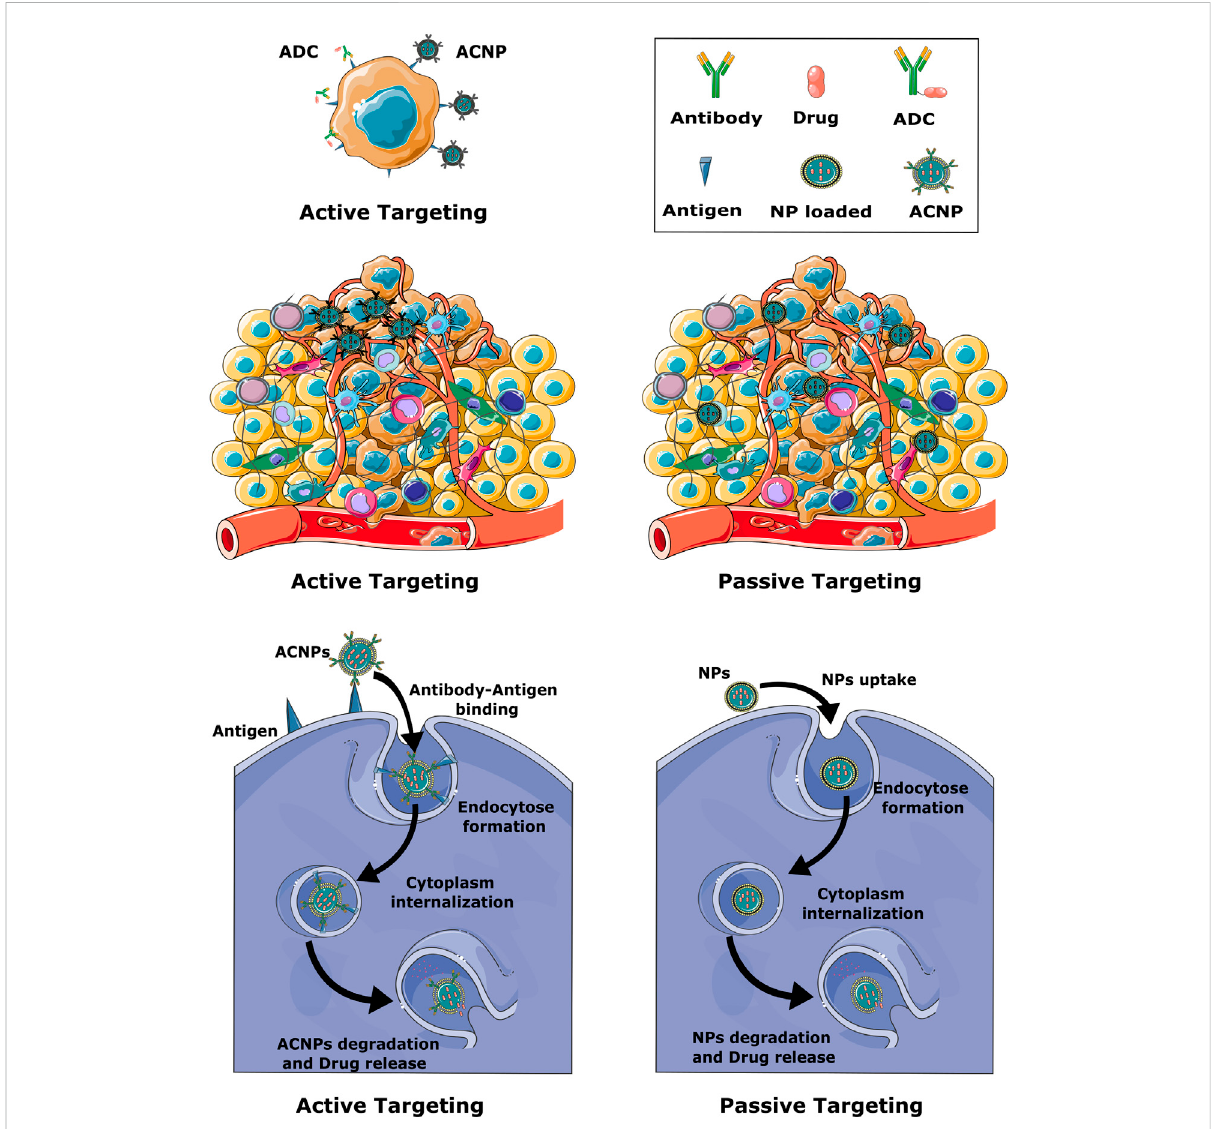
FIGURE 2 Schematicrepresentationofactiveandpassivetargetingmechanisms.Activetargetingisbasedonthepresenceofantibodies onthesurfaceof the NP. In passive targeting, NPs mainly diffuse through leaky blood vessels and accumulate in the tumor tissue due to the EPR effect, while active targeting promotes the accumulation of NPs in the immediate vicinity of tumor cells. Formation of an antibody-antigen complex on the surface of cancer cells greatly facilitates endocytosis of the